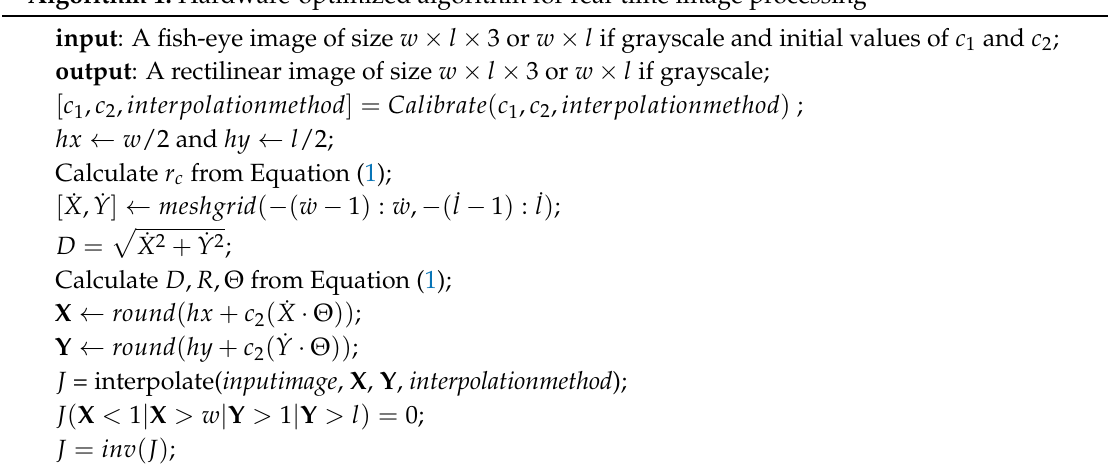
Algorithm 1: Hardware-optimized algorithm for real-time image